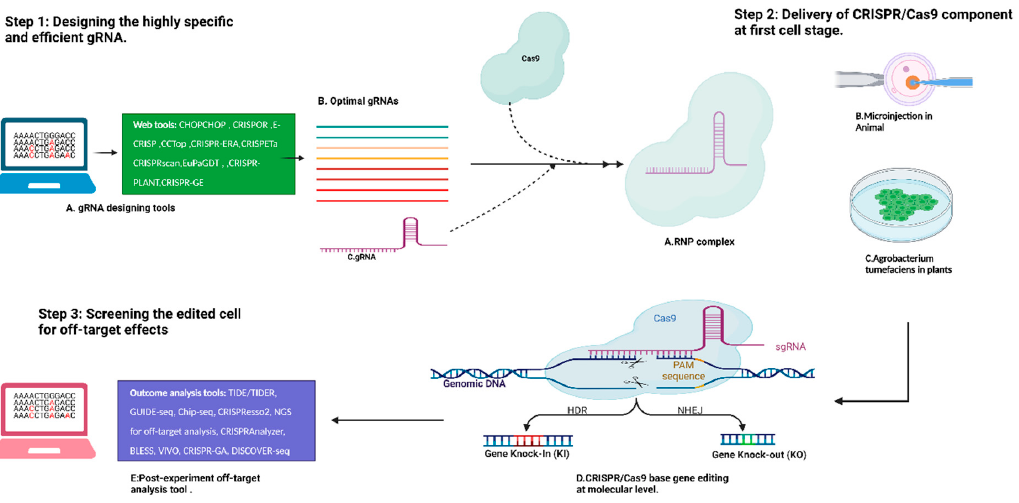
Figure 2. Schematic representation of three key steps of CRISPR/Cas9-based genome